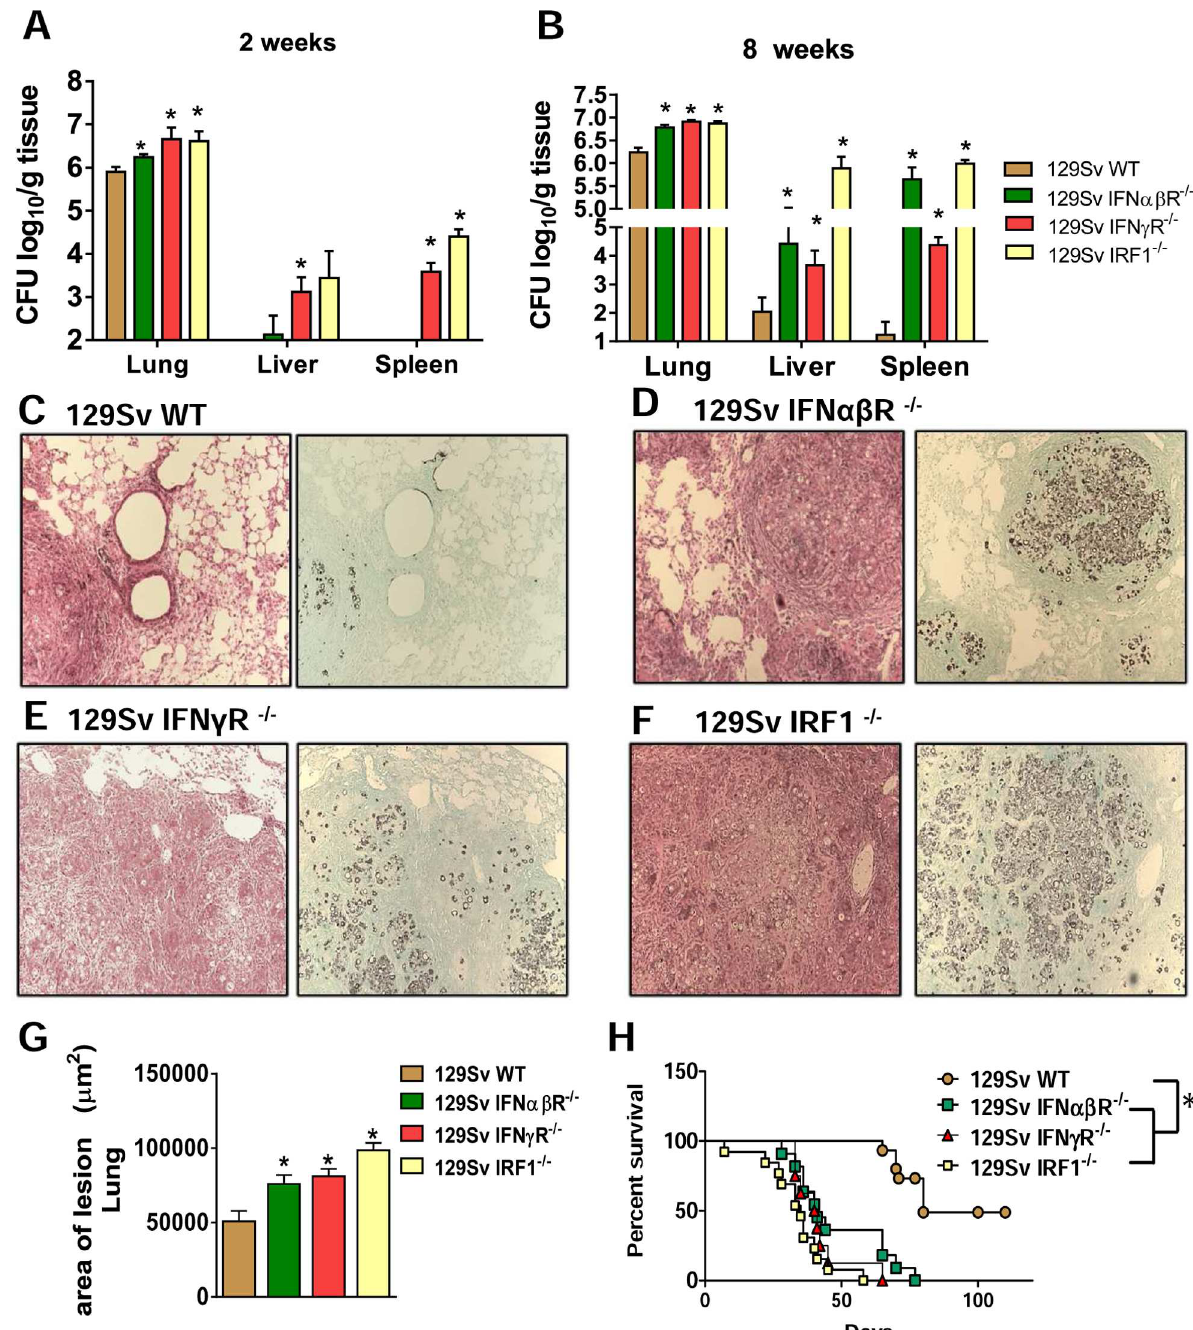
Fig 4. Absence of type I IFN signaling during P . brasiliensis infection increasesmortality ratesassociated with increased fungal loads and tissue pathology. Colony-forming unit (CFU) countsfrom organs weredetermined at 2 (A) and8 weeks (B) after P . brasiliensis infectionof 129Sv WT, IFN αβ R − / − , IFN γ R -/- and IRF1 -/- mice. The bars representmeans ± standarderrors of the mean (SEM) of log 10 CFU counts obtainedfrom groupsof 4–5mice. Photomicrographsof lesionsof WT mice (C), IFN αβ R − / − (D), IFN γ R -/- (E) andIRF1 -/- (F) mice at week 8 of infectionwith 1 × 10 6 P . brasiliensis yeasts. Stainingof lesionswas performedwith hematoxylin-eosin(left panels)and Grocott (right panels).(G) Total area of pulmonarylesionsat week 8 after infection.(H) Survival times of the four studied mousestrains infectedi.t. with 1 × 10 6 P . brasiliensis yeast cells were determined in a periodof 110 days. Data representthe means ± SEM of at least 10 mice/group and are representative of two independent experiments with equivalent results. ( * p < 0.05).